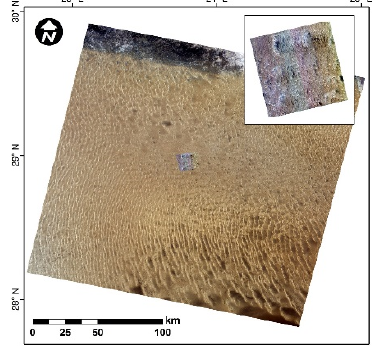
Figure 2. KOMPSAT-3A imagery at the Goheung site